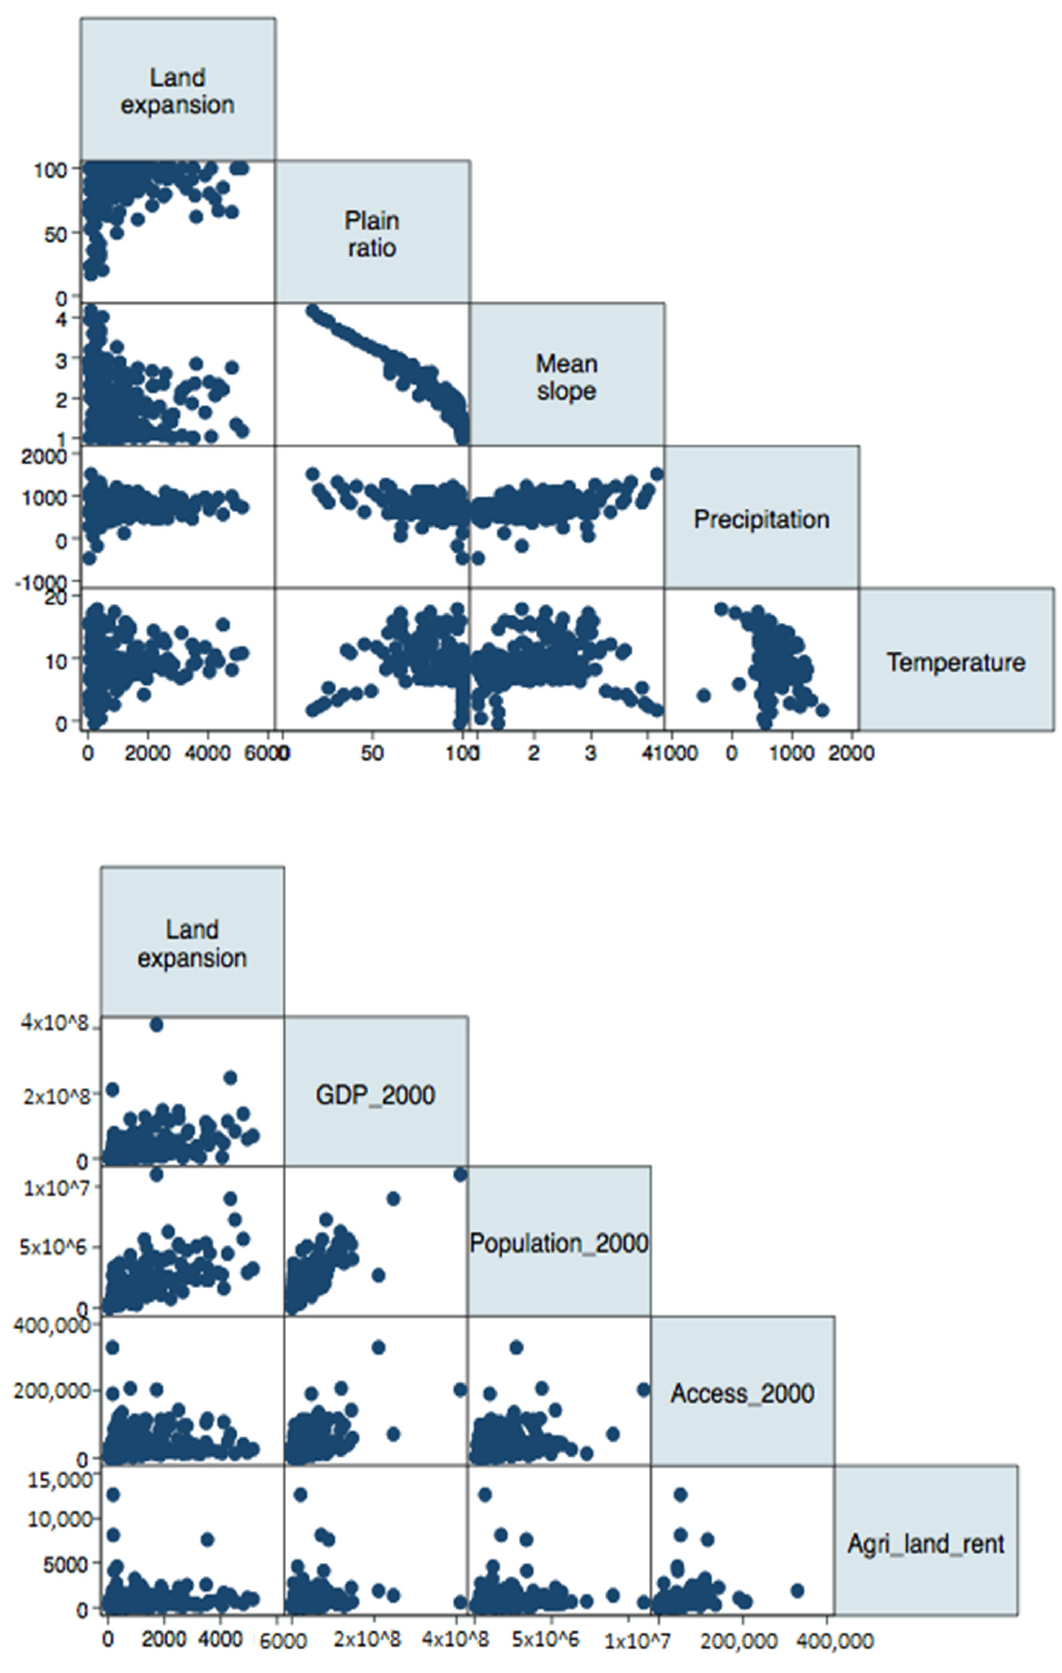
Figure A3. Examples of correlations among selected variables.